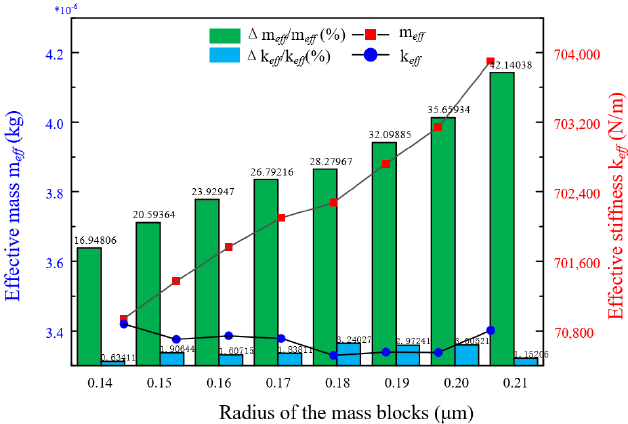
Figure 3. The decoupling effect varies with the radius of mass blocks.